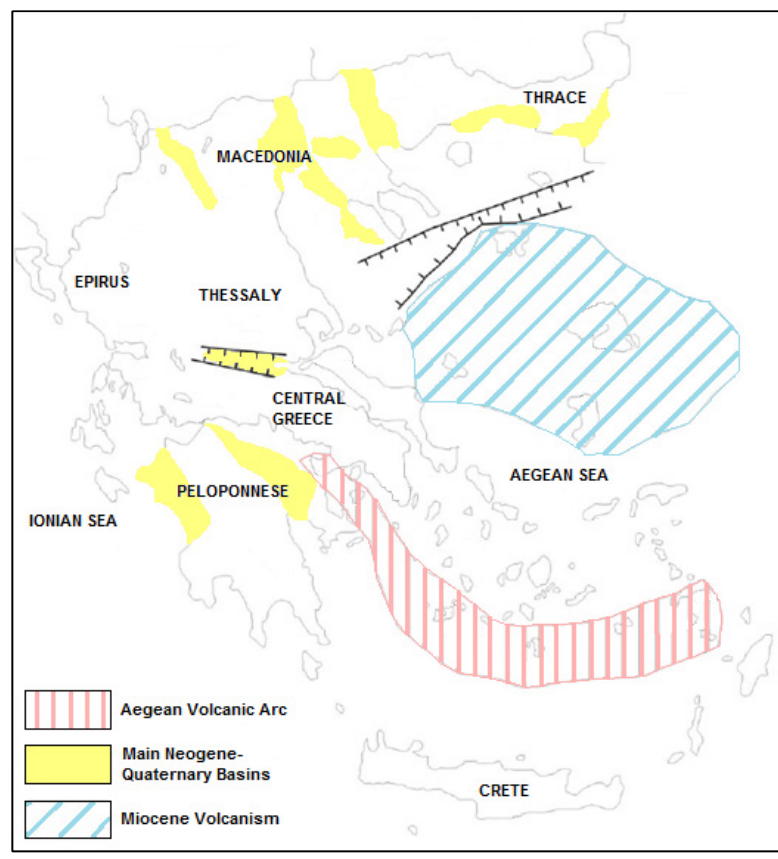
Figure 3. Greece’s principal geotectonic structures (Source: [37]).